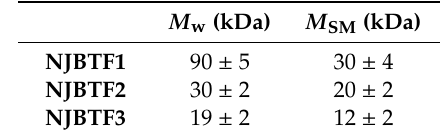
Samples in 0.1 M PBS, pH 7.0. Weight average molecular weights, M w , from sedimentation equilibrium. Loading concentration is 0.4 mg / mL. Values extrapolated to c = 0, Scheraga-Mandelkern estimates M SM ( < M w for polydisperse systems).